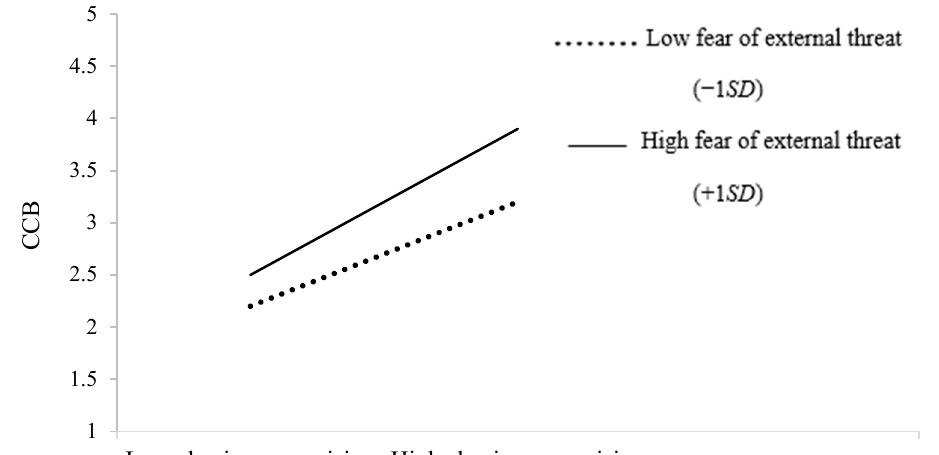
Figure 3. The moderating role of subordinates’ fear of external threats in the relationship between abusive supervision and CCB. Note: CCB = compulsory citizenship behaviors.